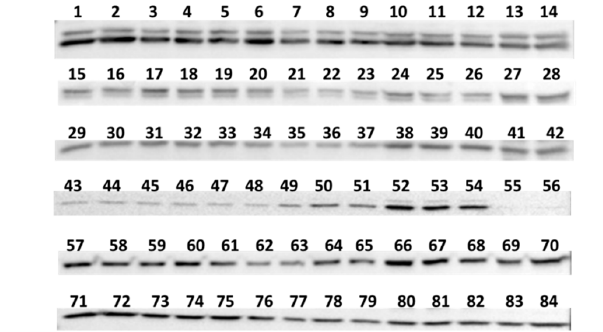
Figure 3. ( A , B ) p -EKR/ERK and p -AKT/AKT protein levels (after normalization to Glyceraldehyde 3-phosphate dehydrogenase GAPDH) with Western-blot (WB) images ( E ) below the graph (*-significant p -value). ( C , D )—detailed table of p -EKR/ERK and p -AKT/AKT results and the p -value. ( E ) detailed WB of the various samples.